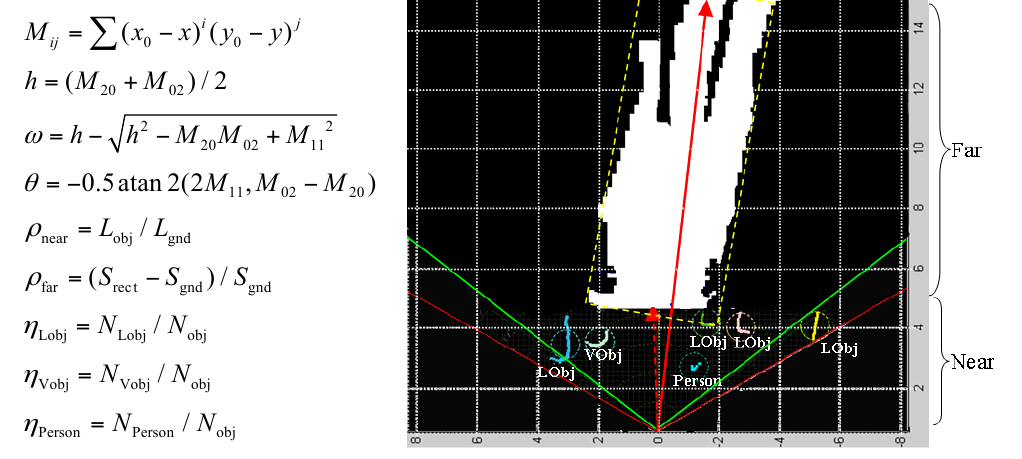
Figure 16. Definition of walking context measurements.